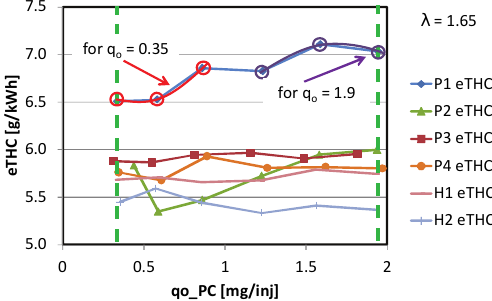
Fig. 10. Selection of points for emission intensity determination by extreme fuel doses qo_PC